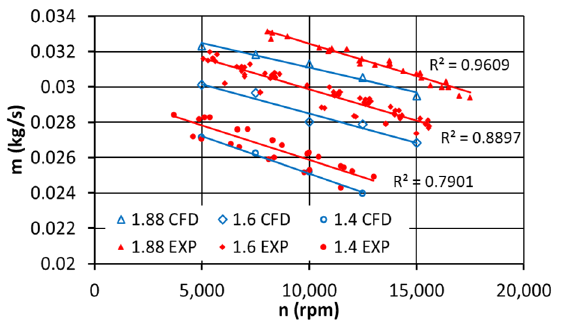
Figure 12. Mass flow rate as a function of rotational speed for different pressure ratios.